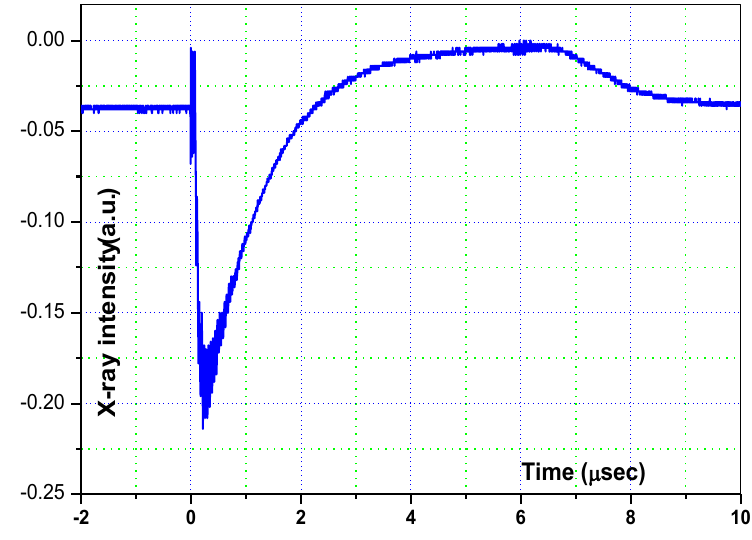
Figure 9. Signal of scintillation hard X-ray detector for nitrogen